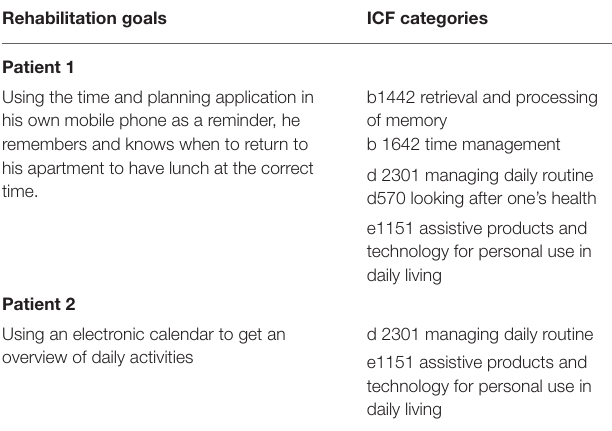
TABLE 4 | Two examples of linking rehabilitation goals to the equivalent ICF categories. Rehabilitation